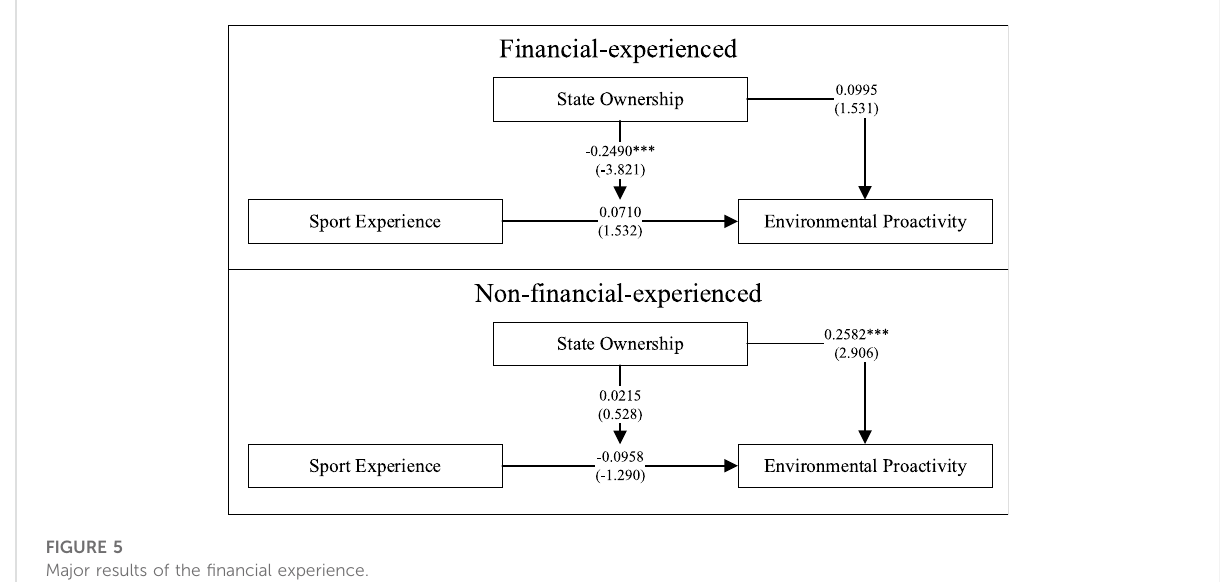
FIGURE 5 Major results of the fi nancial